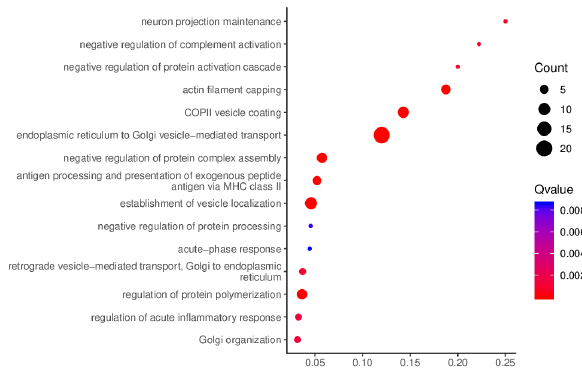
Figure 3: Bubble plot of biological process enrichment for FOLR1 and relevant genes.